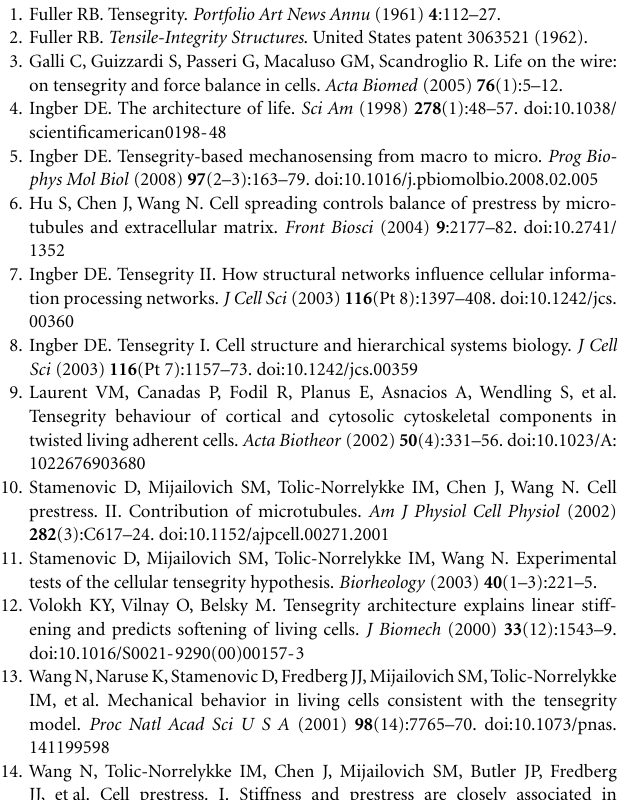
FIGURE 4 | Changes in the ECM after treatment in one neuroblastic tumor . Several stainings (HC and IHC) of (A–E) a primary neuroblastoma and (A’–E’) its post-treatment biopsy are shown.The presented mark-up images of (B,B’) Ret F, (C,C’) Col I F, and (D,D’) GAGs show that these ECM elements are increased in NPNB. Regarding blood vessels (E,E’) , the amount of does not seem to change after treatment but the type of vessels has changed in